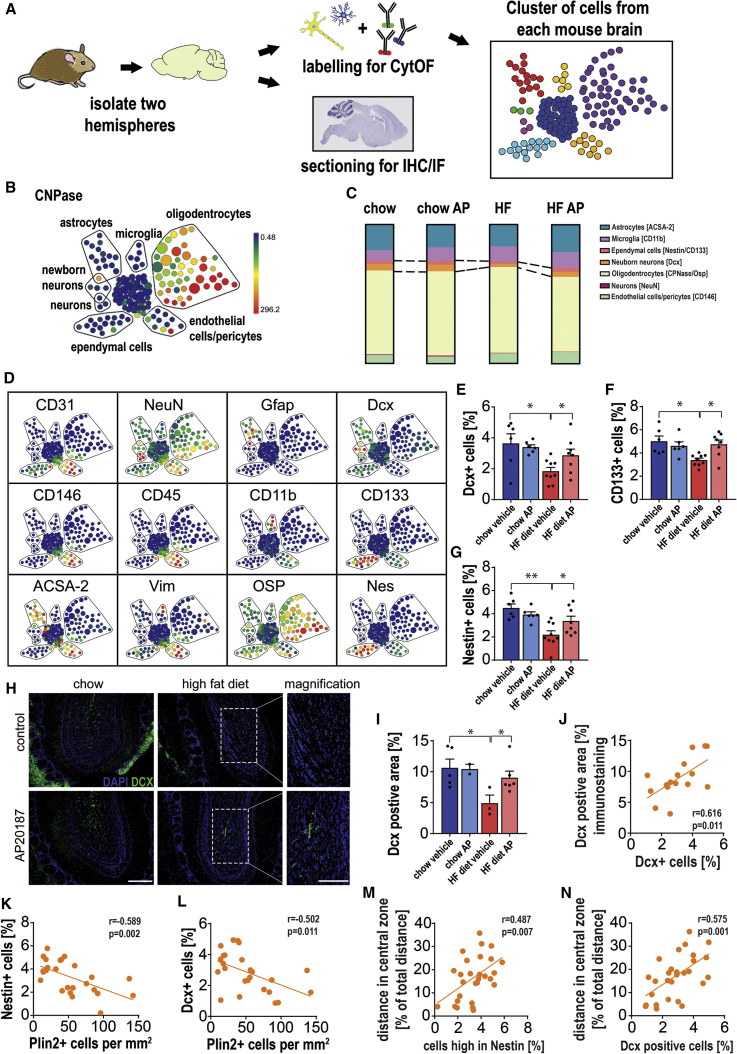
Clearance of Senescent Cells Partially Reverses the Neural Progenitor Cell Depletion Induced by Obesity(A) Each hemisphere of INK-ATTAC lean and high-fat (HF) mouse brains was either dissociated into a single-cell suspension or processed for IHC/IF. Dissociated brain cells were labeled with metal-conjugated antibodies and processed for cytometry by time of flight (CyTOF).(B and D) Spanning-tree progression analysis of density-normalized events (SPADE) was performed on brain cell populations identified by markers shown on the micrographs. Heatmap shows the intensity of the antibody signal, and the size of each spot is determined by the number of cells within this population.(C) CyTOF shows differences in brain cell populations of INK-ATTAC chow- and HFD-fed mice, which were treated with vehicle or AP20187.(E–G) Frequencies of cells expressing the markers (E) doublecortin (Dcx) (t(13) = 3.057, p = 0.0092; t(15) = 2.236, p = 0.041), (F) CD133 (t(6.291) = 3.339, p = 0.0146; t(9.674) = 3.383, p = 0.0073), and (G) Nestin (t(13) = 4.405, p = 0.0007; t(15) = 2.217, p = 0.0425) were quantified.(H) Representative images of Dcx staining in the olfactory bulb of chow- and HFD-fed mice treated with vehicle or AP20187 (scale bars, 250 μm). White boxes show magnified regions (scale bars, 200 μm).(I and J) (I) Quantitative analysis of the Dcx-positive area of the granular layer in the olfactory lobe of lean and obese INK-ATTAC mice (t(6) = 2.707, p = 0.0352; U = 1, p = 0.0476) and (J) correlation between area occupied by Dcx+ cells in the granular layer of the olfactory bulb and frequencies of Dcx+ cells from the whole brain measured by CyTOF (r = 0.616, p = 0.0111).(K and L) Correlations (linear regression analysis) between frequencies of periventricular glia exhibiting accumulation of lipid droplets and frequencies of cells expressing markers of neurogenesis and ependymal cells (determined by CyTOF): (K) Nestin (r = −0.5887, p = 0.002) and (L) Dcx (r = −0.5022, p = 0.0105).(M and N) Correlations (linear regression analysis) between distance traveled in the central zone and the frequencies of cells expressing (M) Nestin (r = 0.487, p = 0.0074) and (N) Dcx (r = 0.5749, p = 0.0011) (determined by CyTOF).Data are from n = 5–9 mice per group for (C)–(G); n = 2–6 mice per group for (I); n = 11 mice per group for (J); n = 29 mice per group for (K)–(N). Mean ± SEM plotted. ∗p ≤ 0.05 and ∗∗p ≤ 0.001.